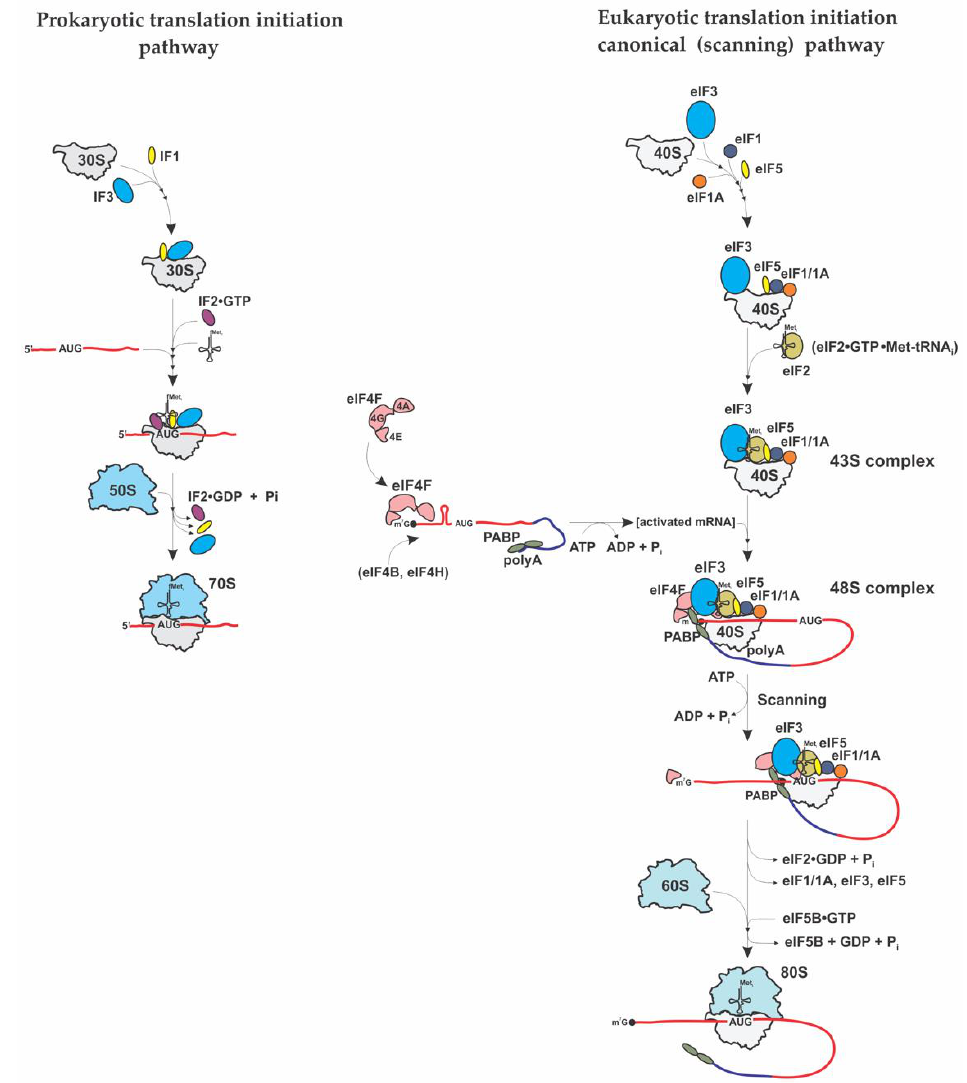
Figure 1. Overview of the major stages of prokaryotic (left) and eukaryotic cap-dependent translation (right) initiation pathways.